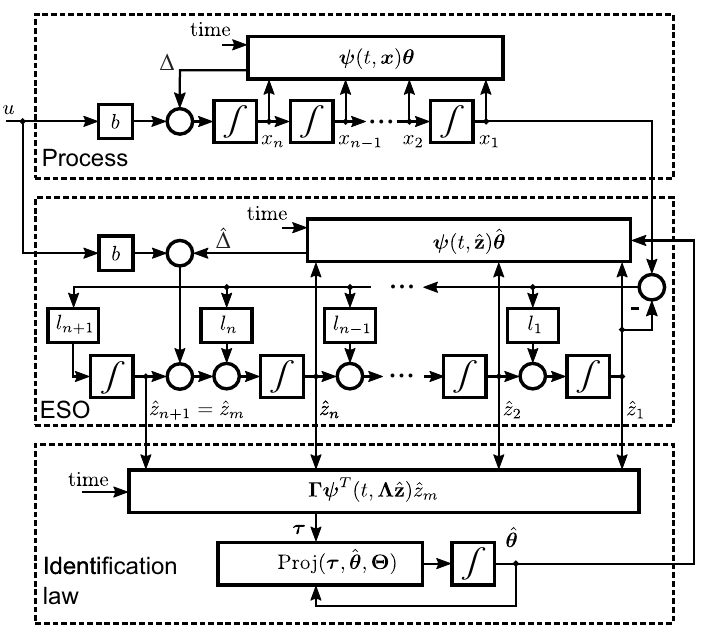
Figure 3. Identification block diagram for the state dependent regressor.